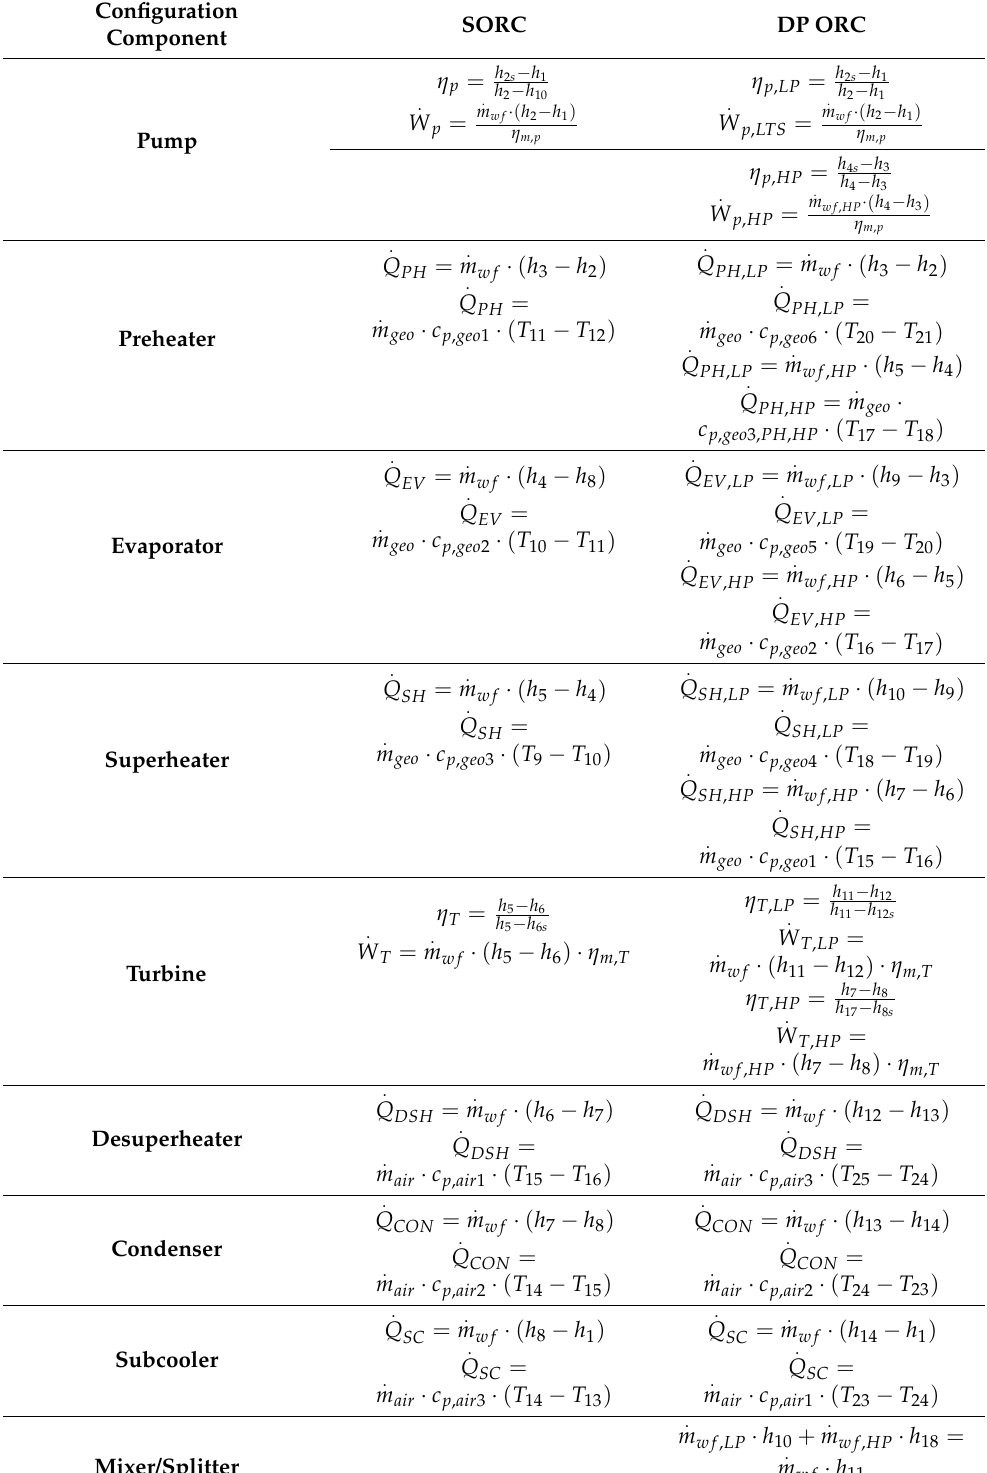
Table A1. The relations for each component (first law analysis) for the SORC and DP ORC configurations. Configuration